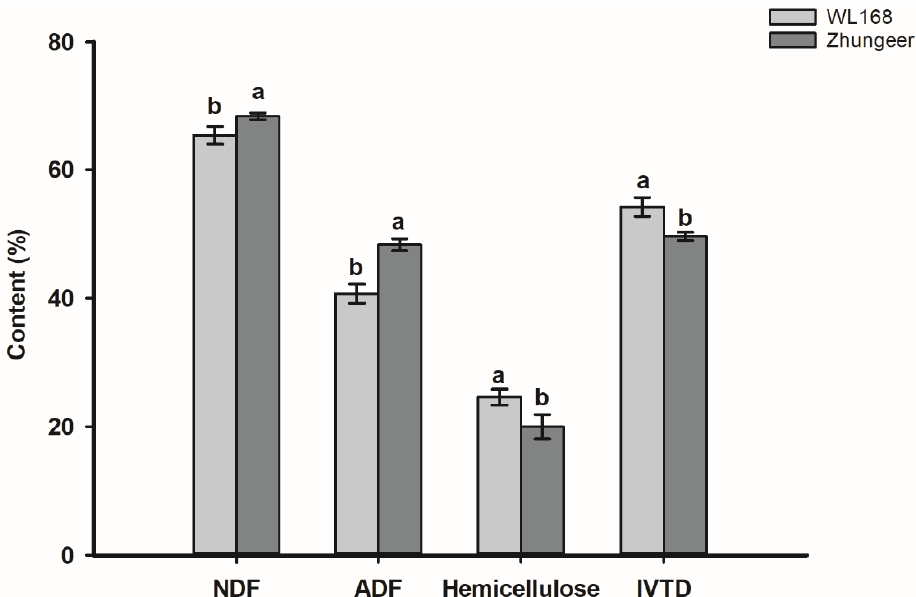
Figure 1. Nutritional quality analysis of stems at initial flowering stage of two alfalfa cultivars. NDF, neutral detergent fiber; ADF, acid detergent fiber; IVTD, in vitro true digestibility. Different letters indicate significant differences at p < 0.05.